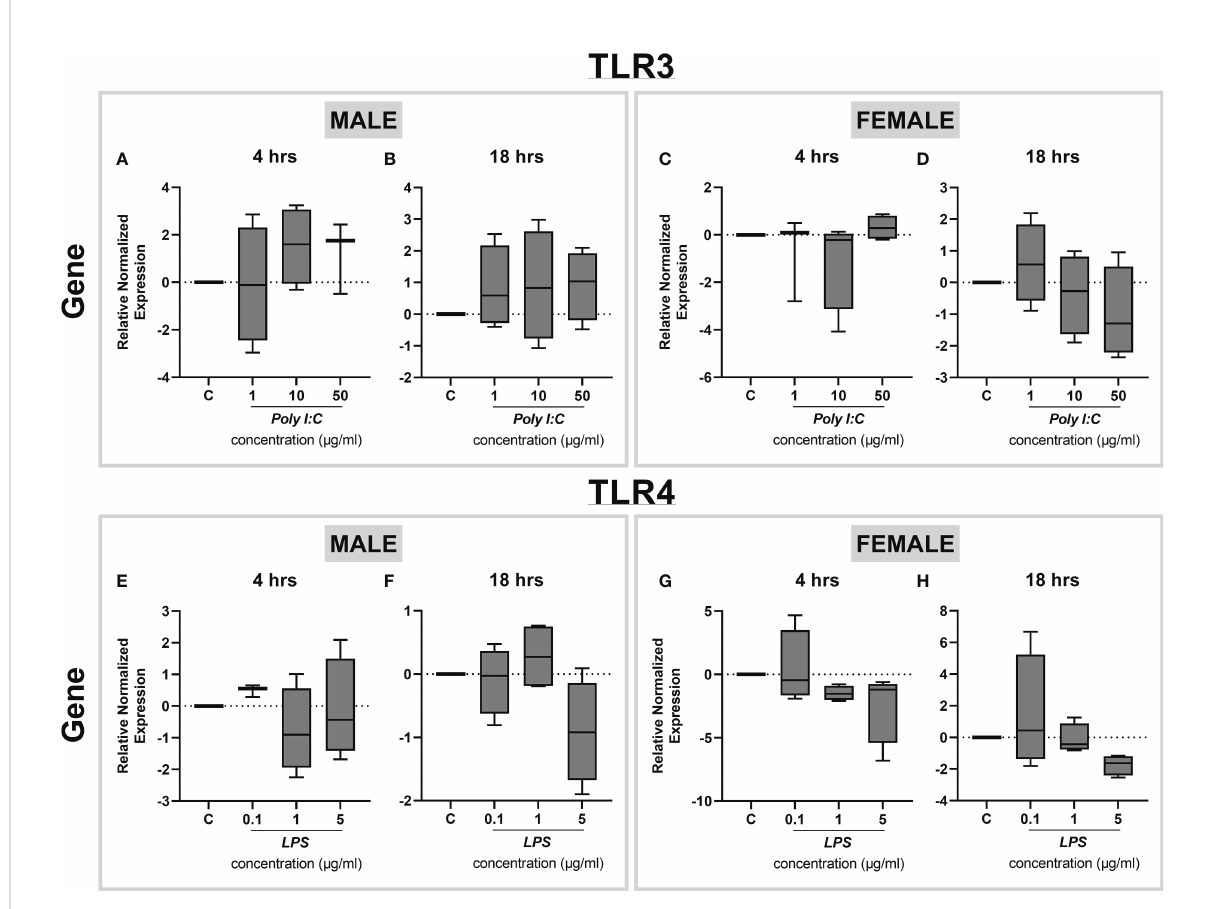
FIGURE 6 Effect of LPS treatment on Tlr3 and Tlr4 expression in rat placental slices. Male and female placentas were exposed to increasing concentrations of Poly I:C (A-D) and LPS (E-H) for 4 and 18 hours, and the gene expression of Tlr3 (A-D) and Tlr4 (E-H) was determined by qPCR analysis. Data are shown as Tukey boxplots,